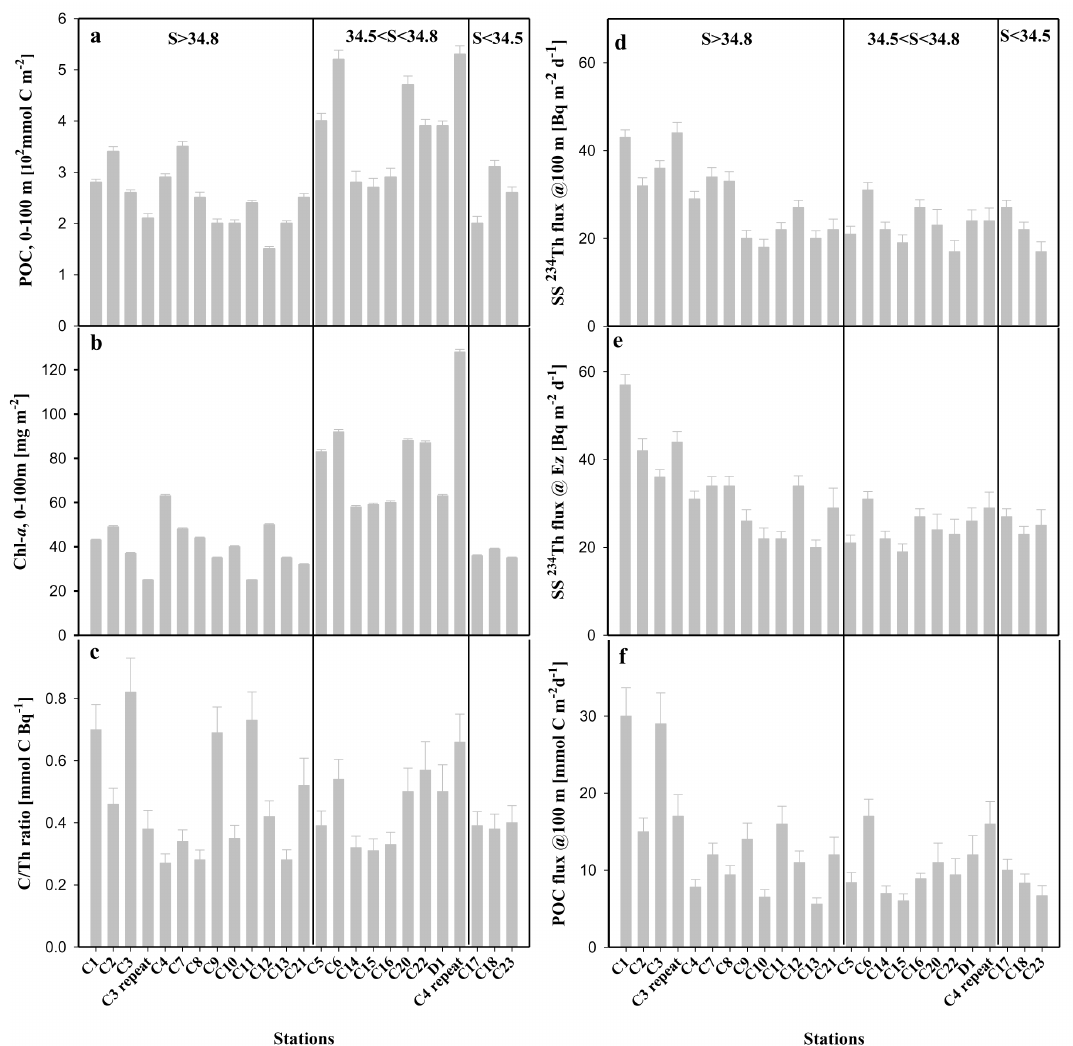
Fig. 9. Spatial distributions of: (a) POC inventory from 0–100m, (b) Chl- a inventory from 0–100m, (c) POC/Th ratio at 100m, (d) 234 Th fluxes at 100m, (e) 234 Th fluxes at the base of the Ez, and (f) POC fluxes at 100m. All stations are separated into three water types: low salinity (S < 34.5), mid-salinity (34.5 < S < 34.8), and high salinity (S > 34.8) waters.